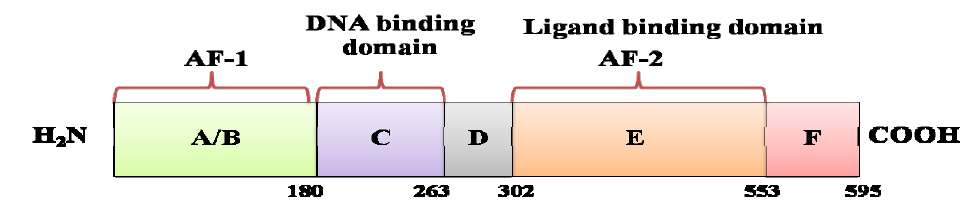
Figure 3. The functional domain of ER α